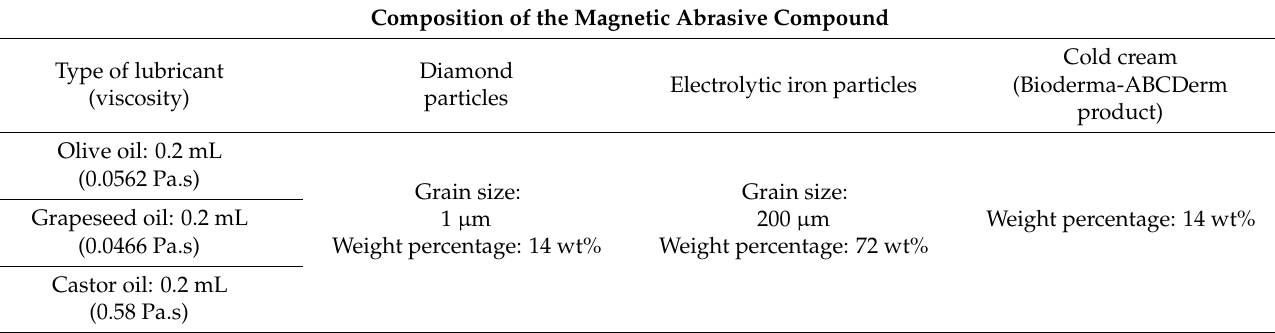
Table 1. Composition of the magnetic abrasive compound according to the type of processing oil. Composition of the Magnetic Abrasive Compound